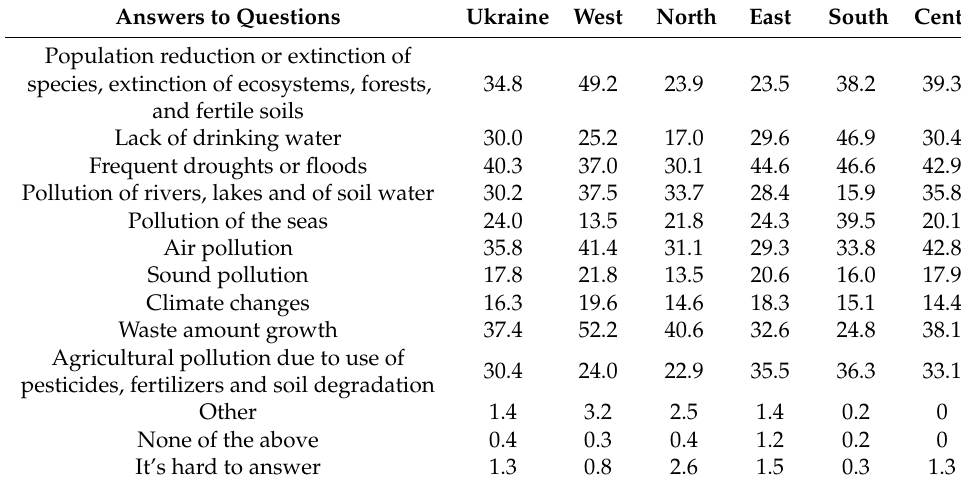
Table 5. The most important environmental issues chosen by the respondents, % of the total number of respondents, multiple choice